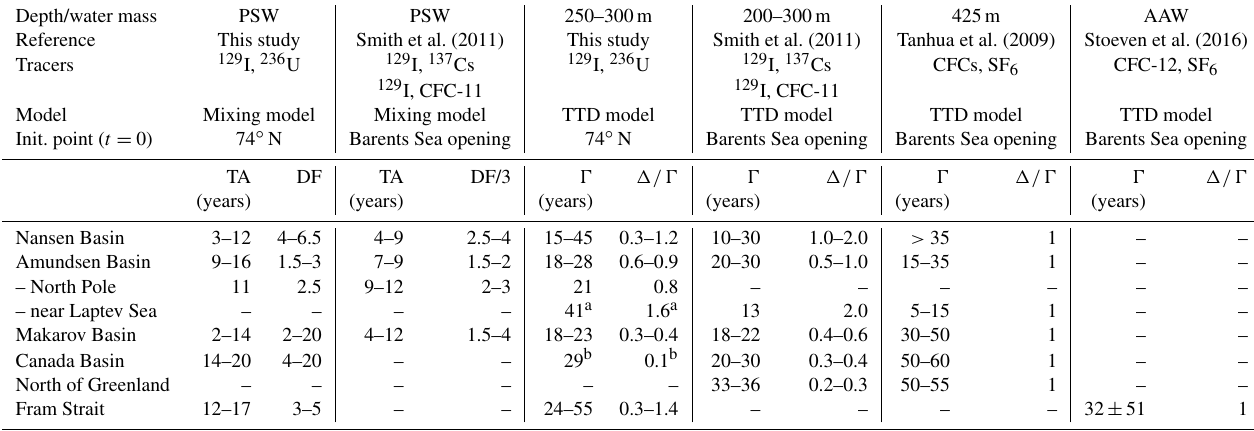
Table 2. Tracer ages (TAs), dilution factors (DFs), mean ages ( (cid:48) ), and (cid:49)/(cid:48) ratios determined from the two age models for the different basins of the Arctic Ocean in Polar Surface Water (PSW) and the mid-depth Atlantic layer are compared to those from earlier studies. Given ranges correspond to minimum and maximum values for stations within the basin for all sampling years. For comparison to Smith et al. (2011) tracer ages and dilution factors were normalized to the entrance of the Arctic Ocean (dilution factors have been divided by 3 to account for dilution from 60 ◦ N, where the input function from Smith et al. (2011) was defined, to the Barents Sea). For Tanhua et al. (2009) and Stöven et al. (2016), the time t = 0 is set by the isolation of waters from the atmosphere, which was here approximated as the Barents Sea opening. AAW: Arctic Atlantic Water; Init. point: initialization point.